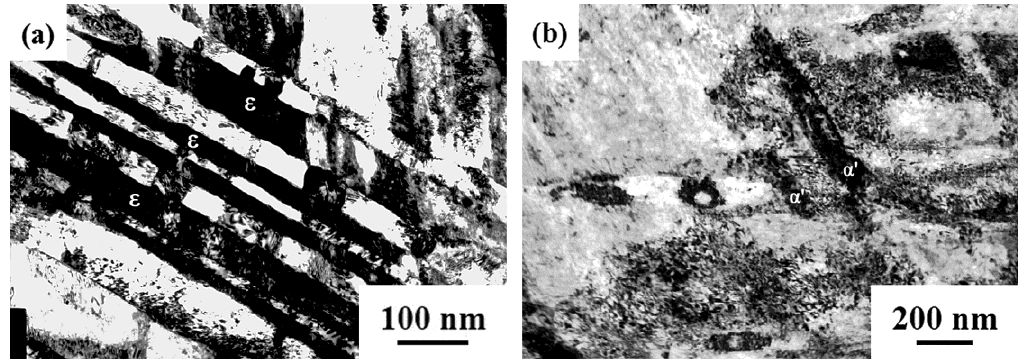
Figure 6. TEM micrographs of the CR specimen illustrating ( a ) ε-martensite strips in the austenite matrix, ( b ) α′-martensite at the intersections of ε-martensite strips.